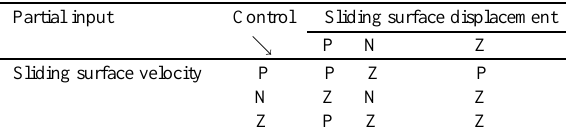
Table 1 Rule base of fuzzy sliding mode controller